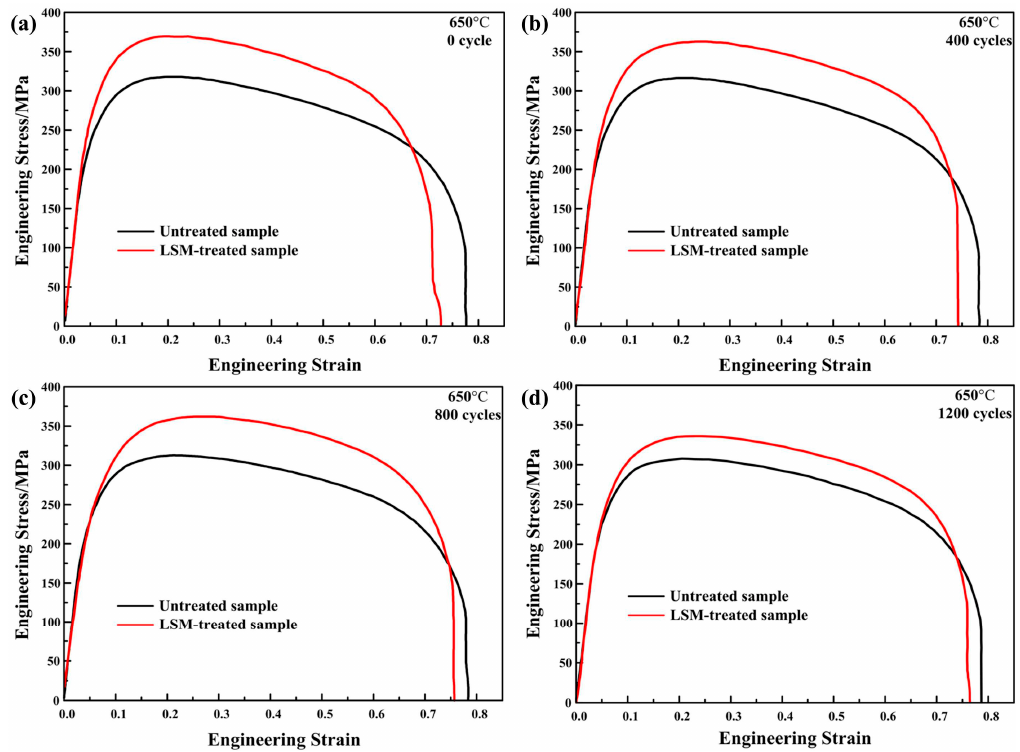
Figure 10. Stress-strain curves of LSM-treated specimen and untreated specimen at 650 °C and for thermal fatigue cycles equal to ( a ) 0 cycle, ( b ) 400 cycles, ( c ) 800 cycles, and ( d ) 1200 cycles.